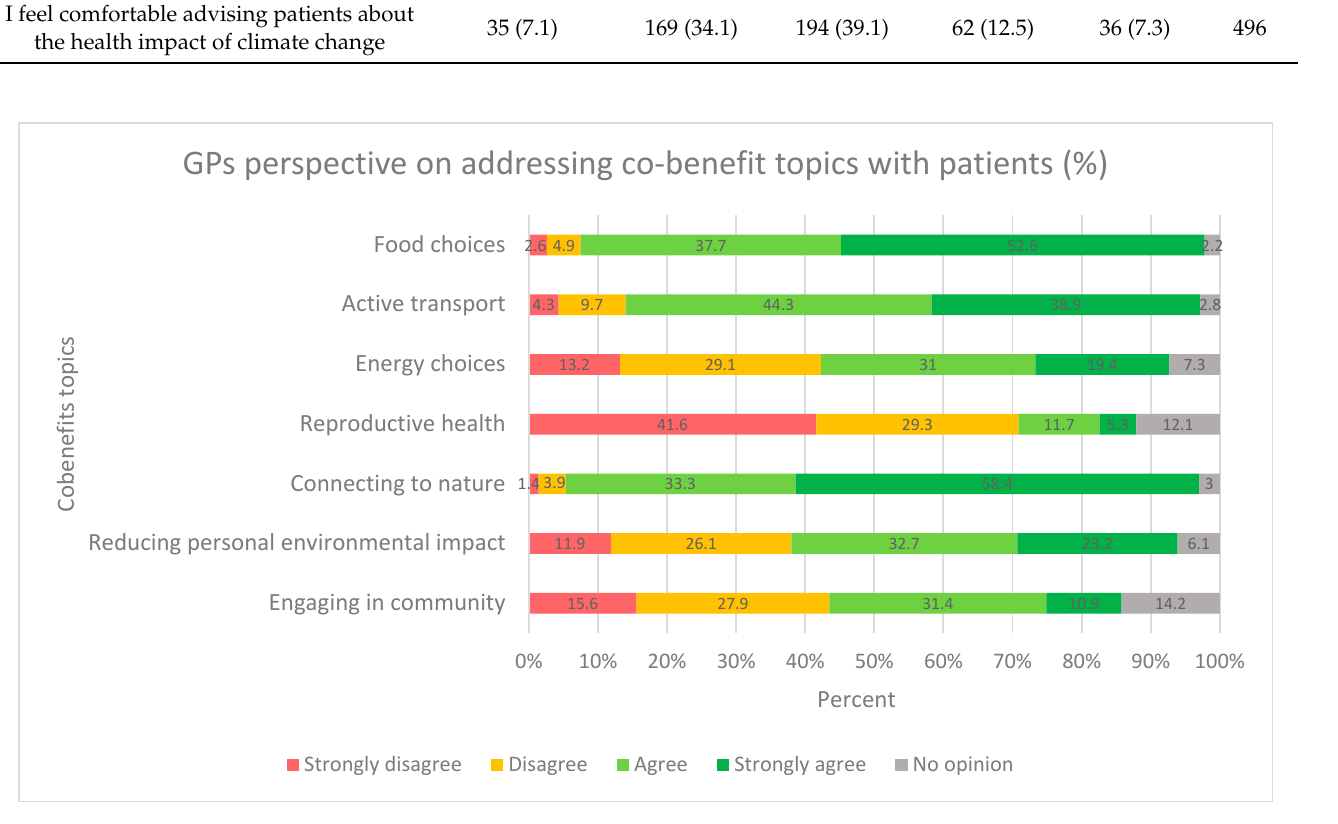
Figure 2. Willingness of respondents to address co-benefit topics from the WONCA declaration with patients. (%) N = 497.